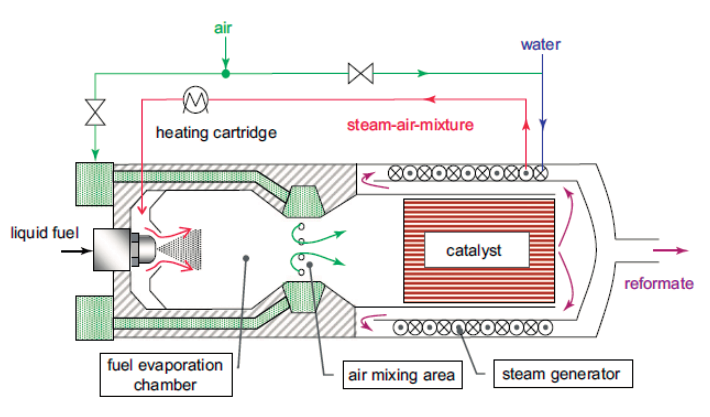
Figure 17. Schematic of ATR 7 [32].